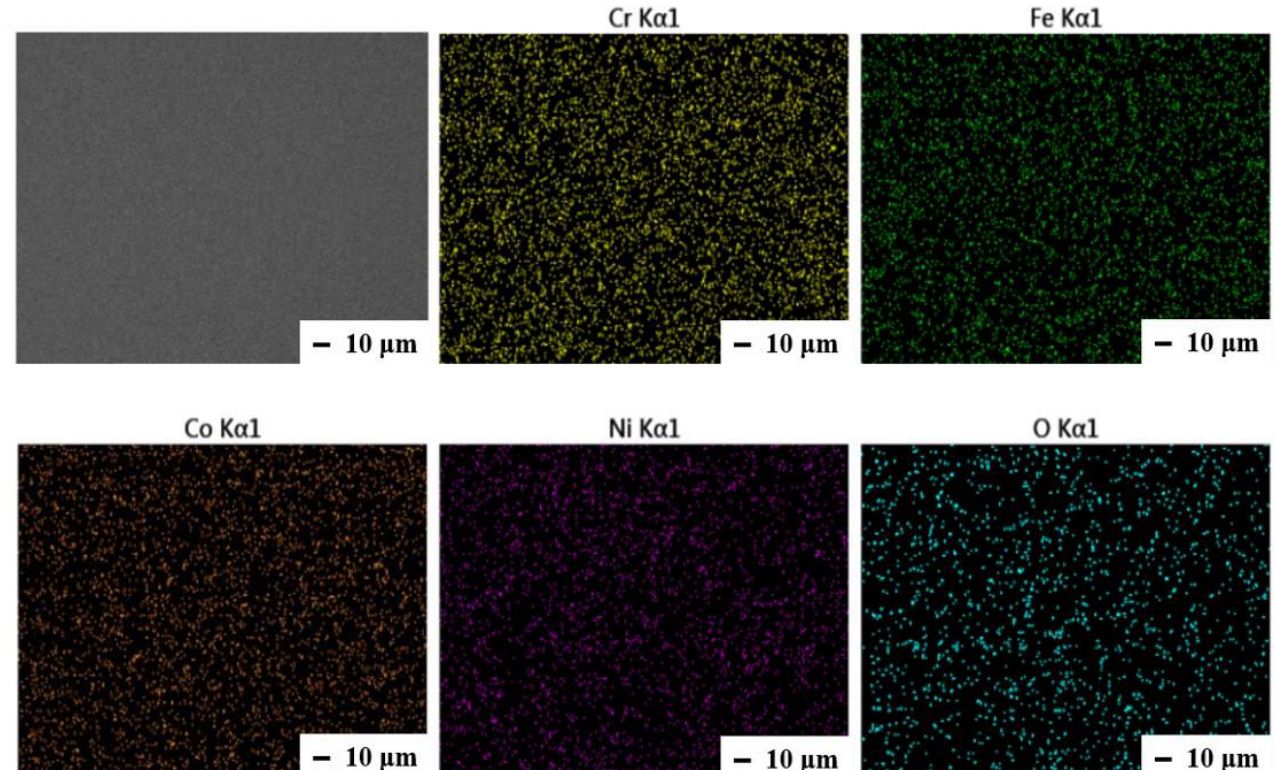
Figure 1. SEM image and EDS mapping results of an as-deposited film (S9) on Si substrate.